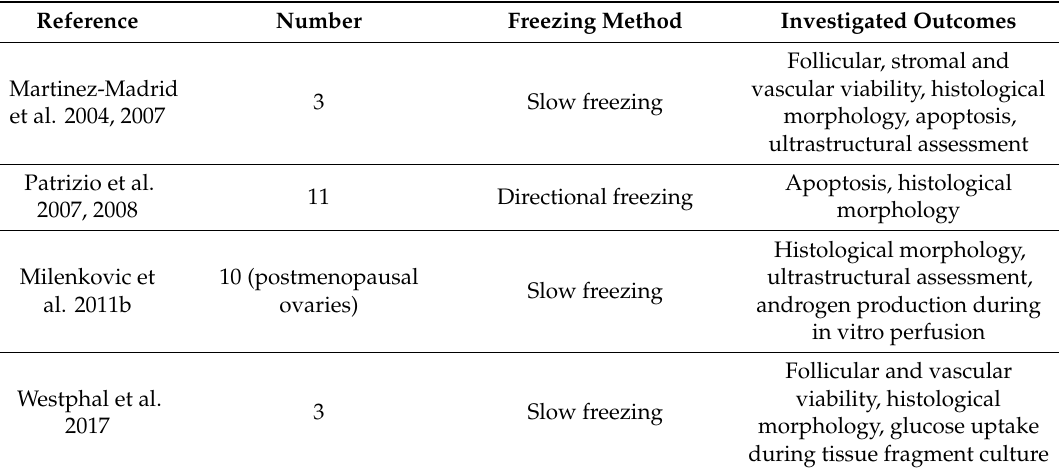
Table 4. Cryopreservation protocols applied to human